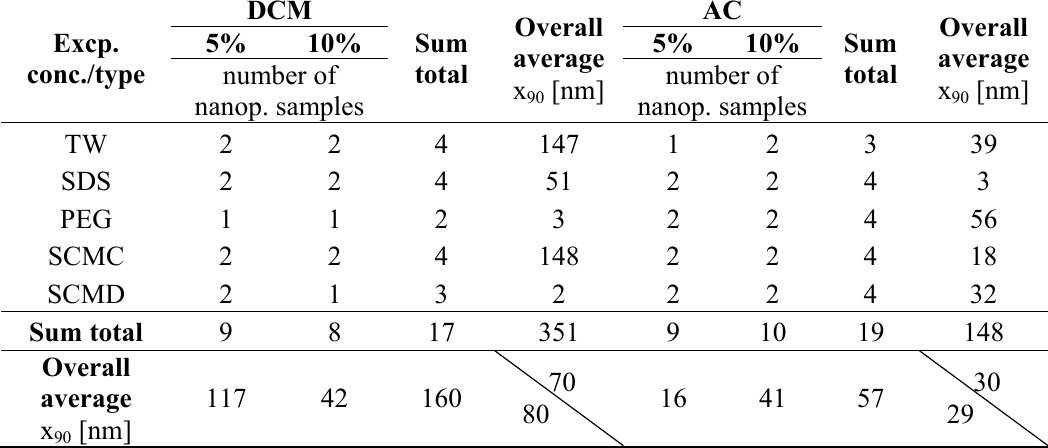
Table 6. View of formed samples of nanoparticles ( ≤ 900 nm) depending on solvents and type and amount of excipients. (conc. = concentration; excp. = excipient; dichloromethane